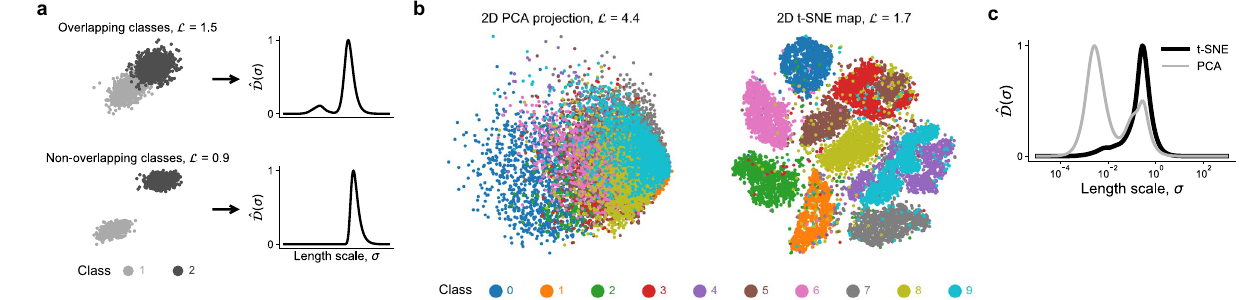
Figure 8. Using the cost function to detect overlap between classes in categorical data. ( a ) Toy dataset composed of two clouds. The first case emulates a projection where two classes overlap, while the second case presents good separation between classes. The cost associated with overlapping classes is higher. ( b ) 2D PCA projection and 2D t-SNE map of the MNIST handwritten digits dataset. With a significant overlap between classes seen in the PCA projection, the associated cost is higher than for the t-SNE map. ( c ) The ˆ D (σ) curves corresponding to the 2D PCA projection and the 2D t-SNE map of the MNIST handwritten digits